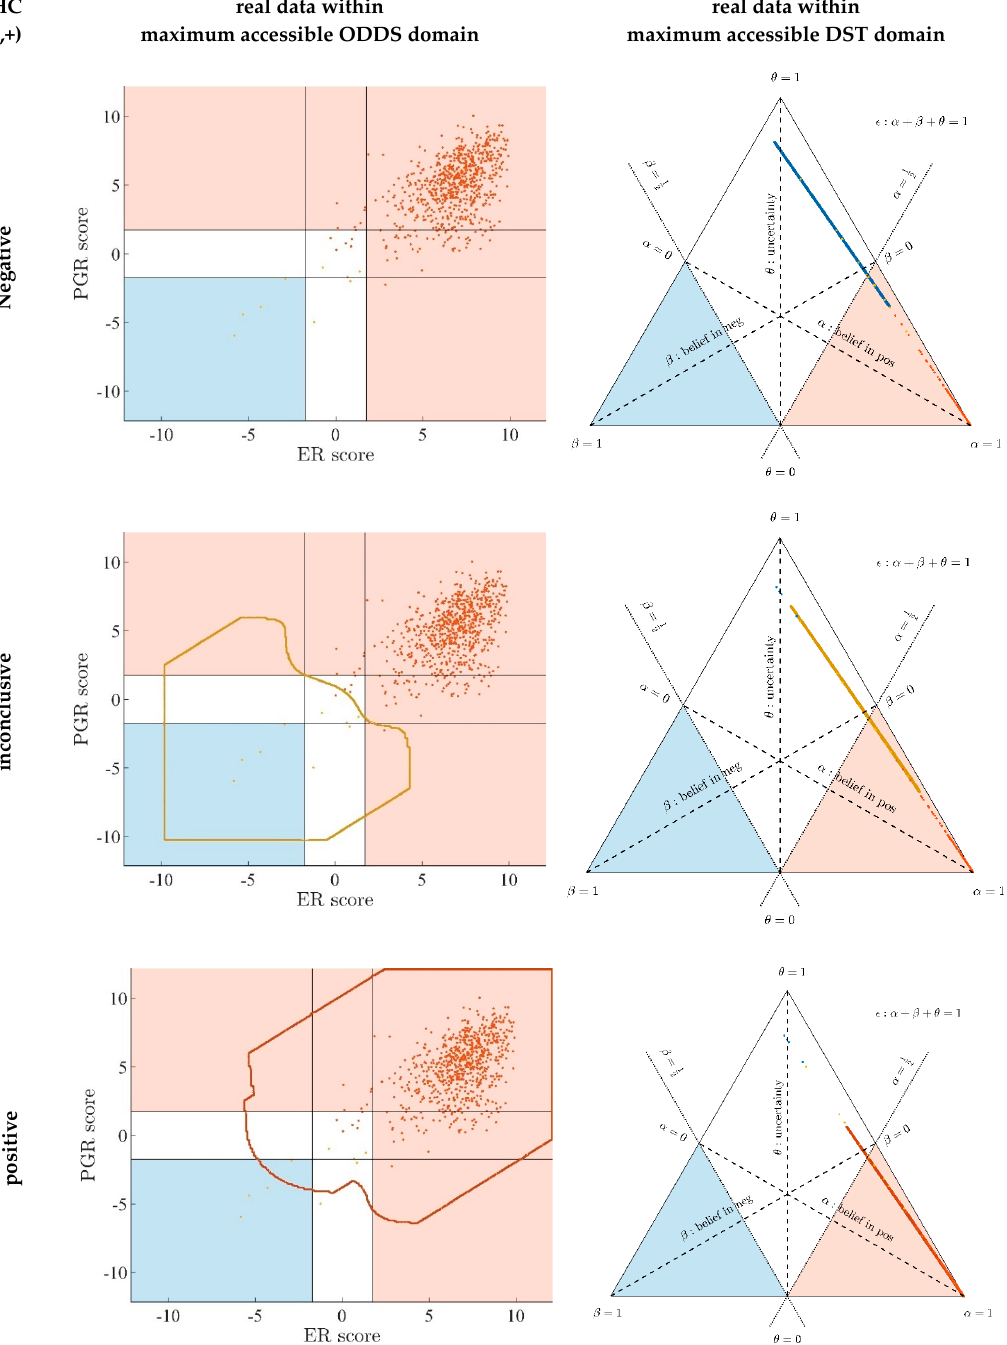
Figure A4. Real sample data within maximum accessible domains for IHC = (+,+). For general features of display see caption to Figure A3.